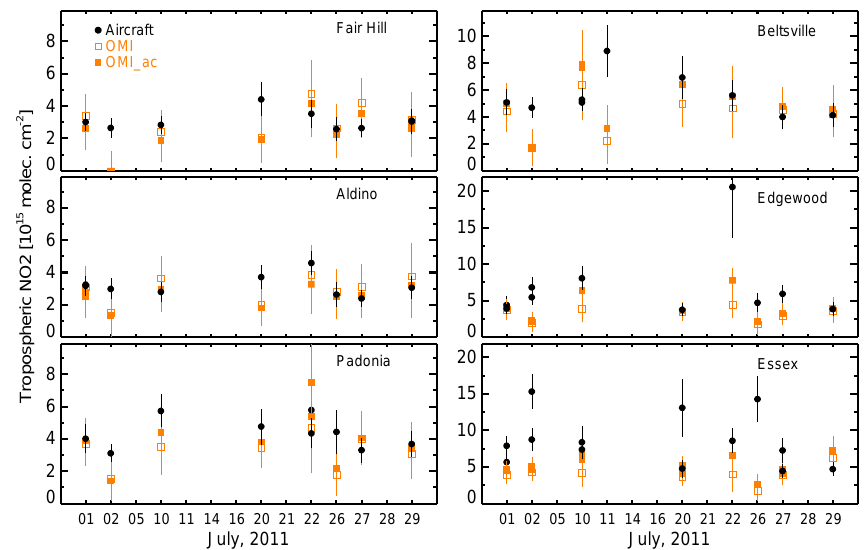
Figure 5. Comparison of tropospheric NO 2 columns retrieved from OMI (squares) with those determined from in situ measurements (filled circles). The figure shows OMI retrievals performed using GMI NO 2 a priori vertical profiles (open squares) and in situ NO 2 measurements (filled squares). Error bars represent errors in the aircraft measurements, extrapolated aircraft profiles, and OMI retrievals.